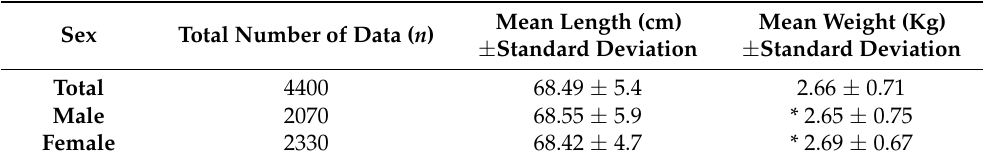
Table 1. Mean length and mean weight of chum salmon ( Oncorhynchus keta ) surveyed in South Korea (* t -test, p <